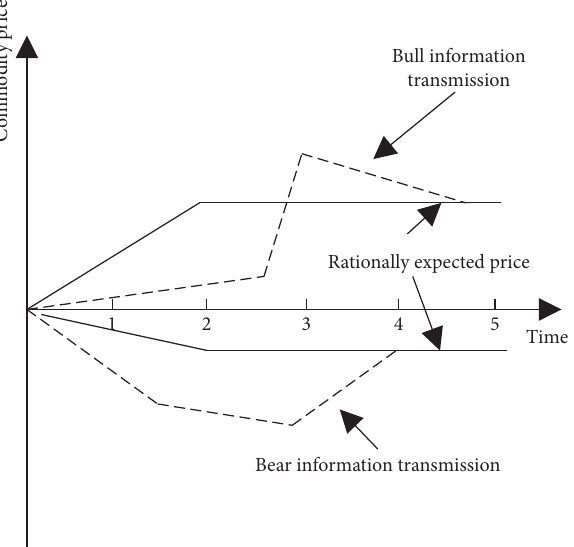
Figure 3: Response of commodity price to different types of information.